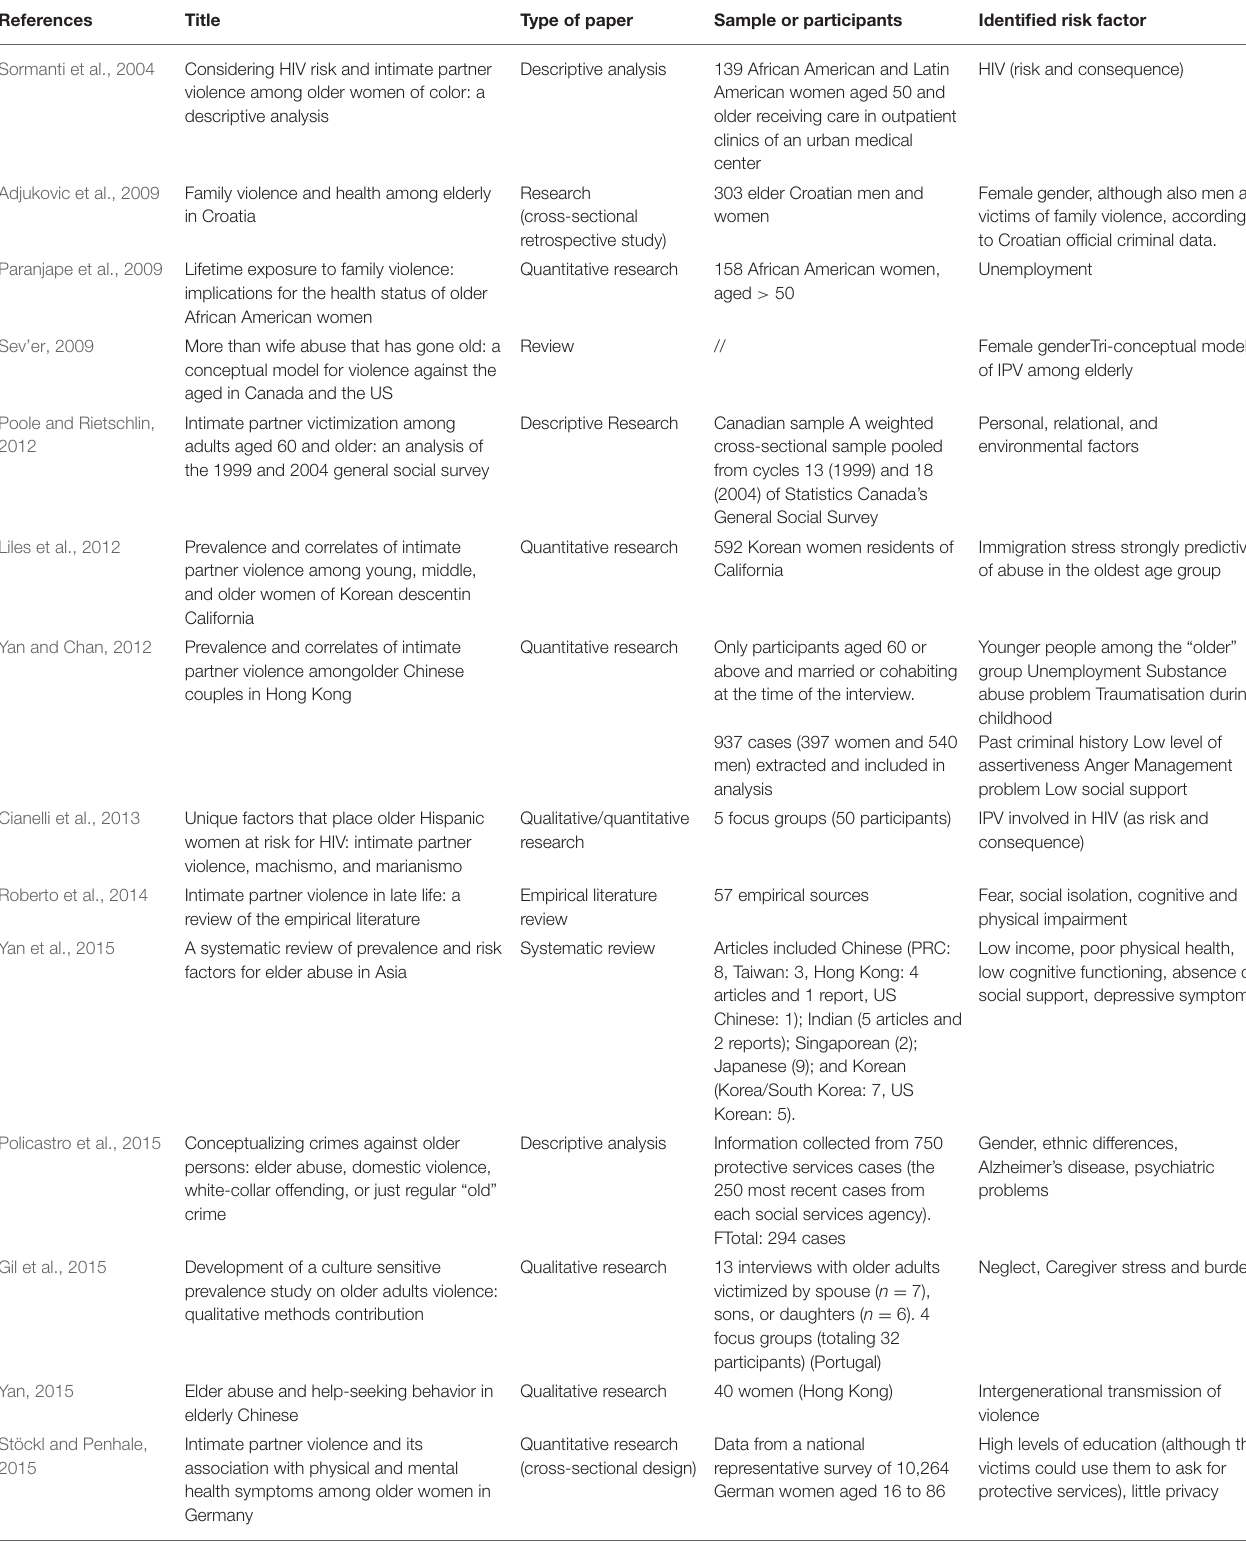
TABLE 2 | Published studies on risk